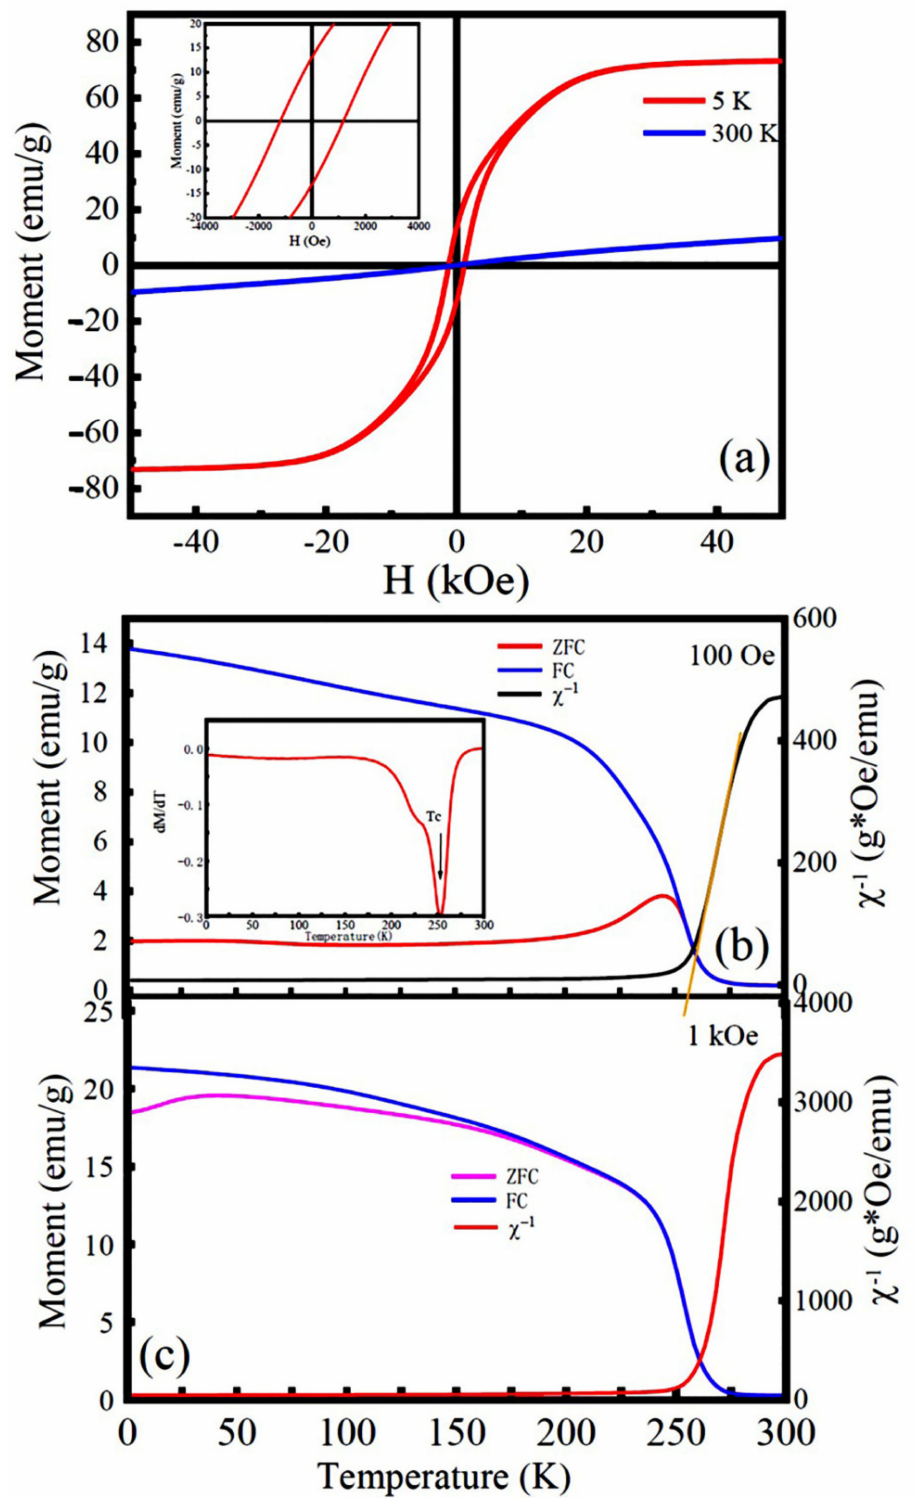
Figure 7. ( a ) M-H hysteresis loops of the LNMO NPs recorded at 5 K and 300 K. Inset is local enlarged M - H curve. ( b , c ) Temperature dependent dc magnetizations measured under ZFC and FC modes with applied magnetic fields of 100 Oe and 1000 Oe, respectively, and the temperature dependence of reciprocal ZFC magnetic susceptibilities, χ − 1 measured at 100 Oe and 1000 Oe (right Y column), respectively. Inset in Figure b is d M ZFC /d T versus temperature to determine the magnetic Curie temperature ( T C